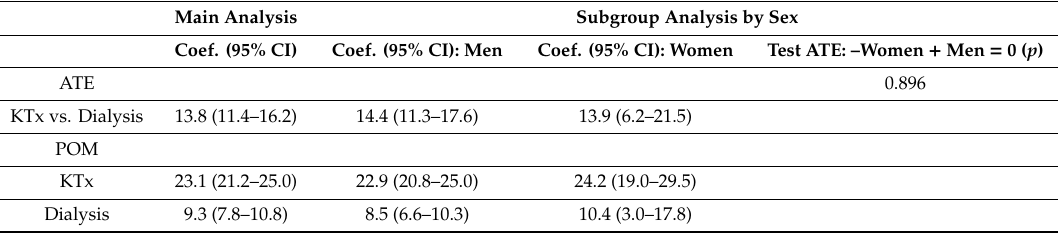
Table 2. Average treatment e ff ect of the treatment on the survival time for patients on the waitlist and subgroup analysis by sex ( n = 2676).